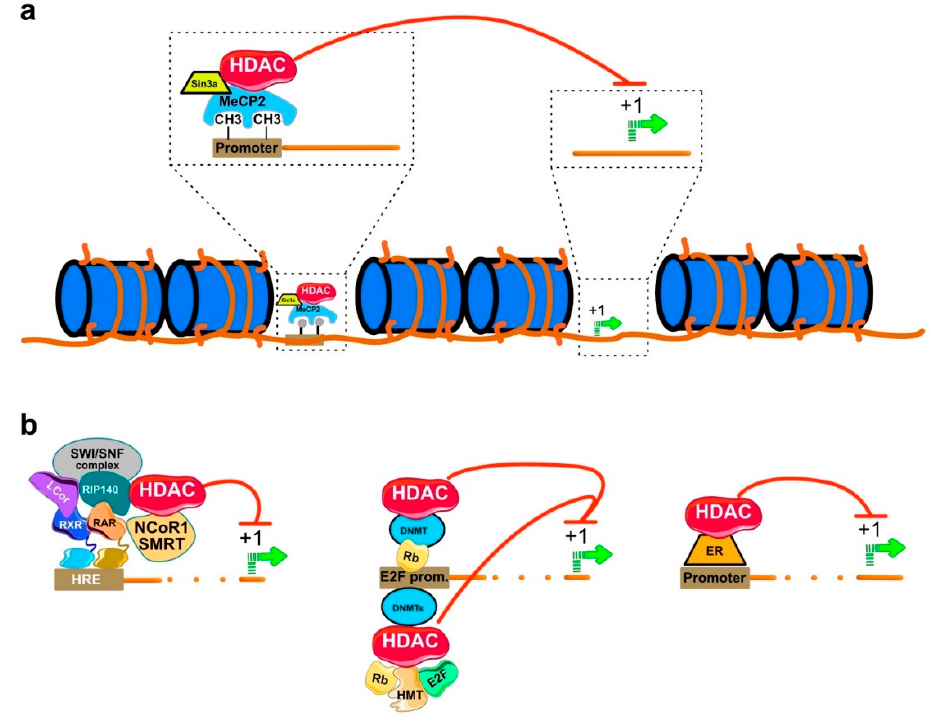
Figure 4. Illustrating the physiological function of HDAC. HDAC can be recruited to gene promoter associated with coregulatory proteins including ( a ) methyl binding protein (MeCP2), ( b ) DNA methyl transferases (DMNT), Estrogen receptor (ER), and transcription factors Rb and E2F, which are responsible for gene silencing and subsequent chromatin remodeling [37].